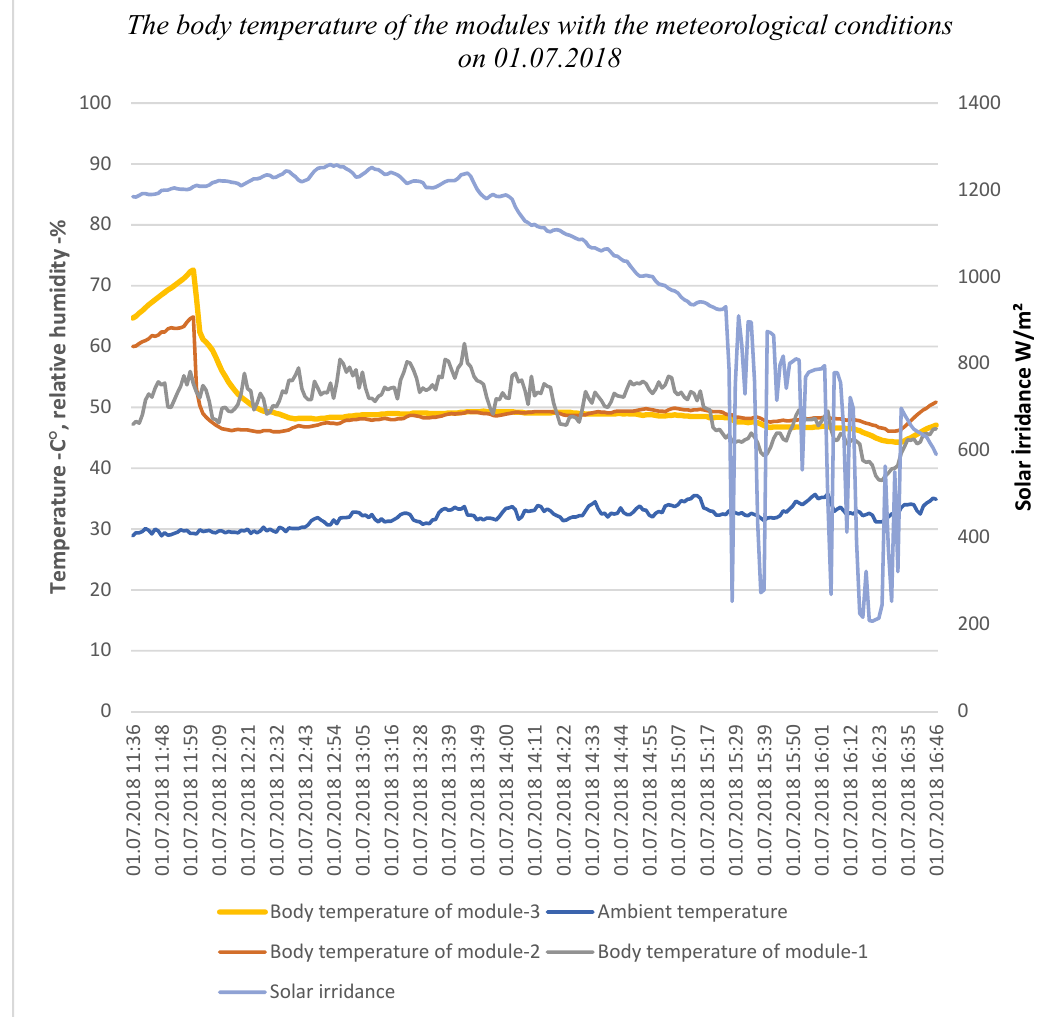
Figure 7. The body temperature of the modules with the meteorological conditions on 01.07.2018.